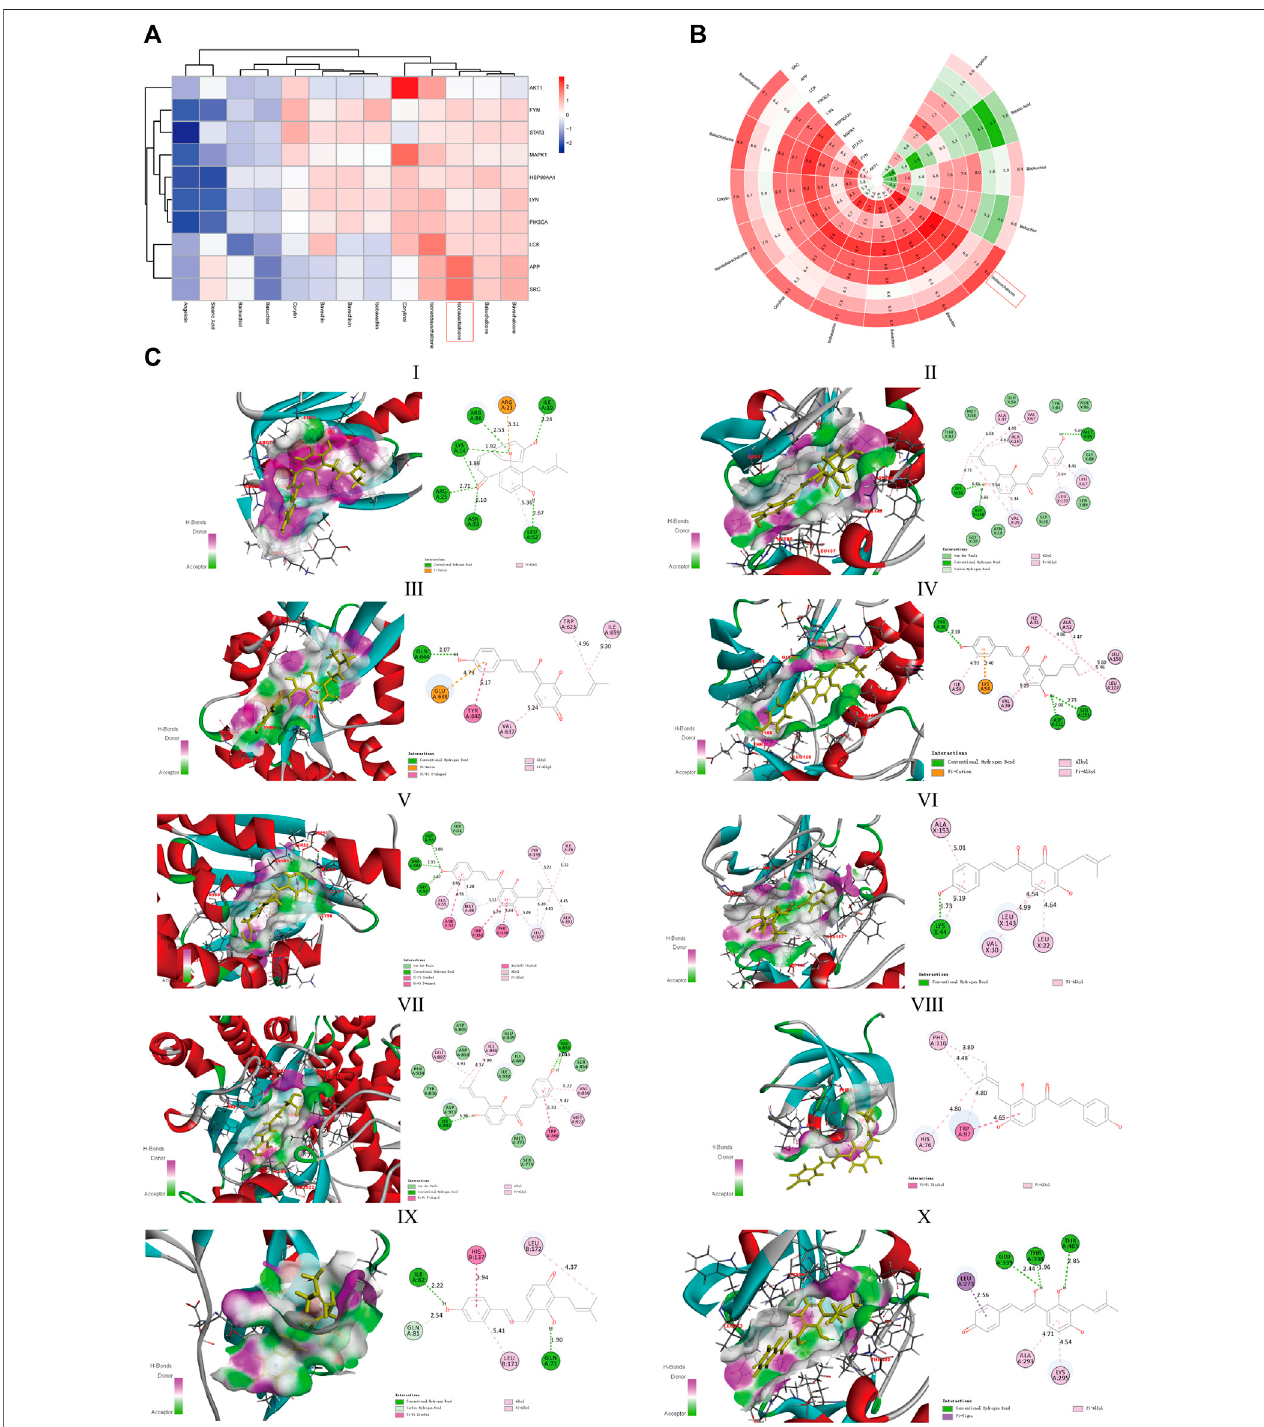
FIGURE 6 | Molecular docking of components and targets. (A) Heatmap of the absolute value of the scores from Discovery Studio with Z-score normalized. (B) PolarheatmapoftheabsolutevalueofthescoresfromAutoDockVinawithZ-scorenormalized.Therednodereferstoastabledockingconformation,whileblueorgreen representing poor interactions, which is suitable for (A,B) . (C) Docked conformation between IBC and 10 core targets. ( Ⅰ ) AKT1, ( Ⅱ ) HSP90AA1, ( Ⅲ ) FYN, ( Ⅳ ) LCK, ( Ⅴ ) LYN, ( Ⅵ ) MAPK1, ( Ⅶ ) SRC, ( Ⅷ ) APP, ( Ⅸ ) STAT3, and ( Ⅹ ) PIK3CA.